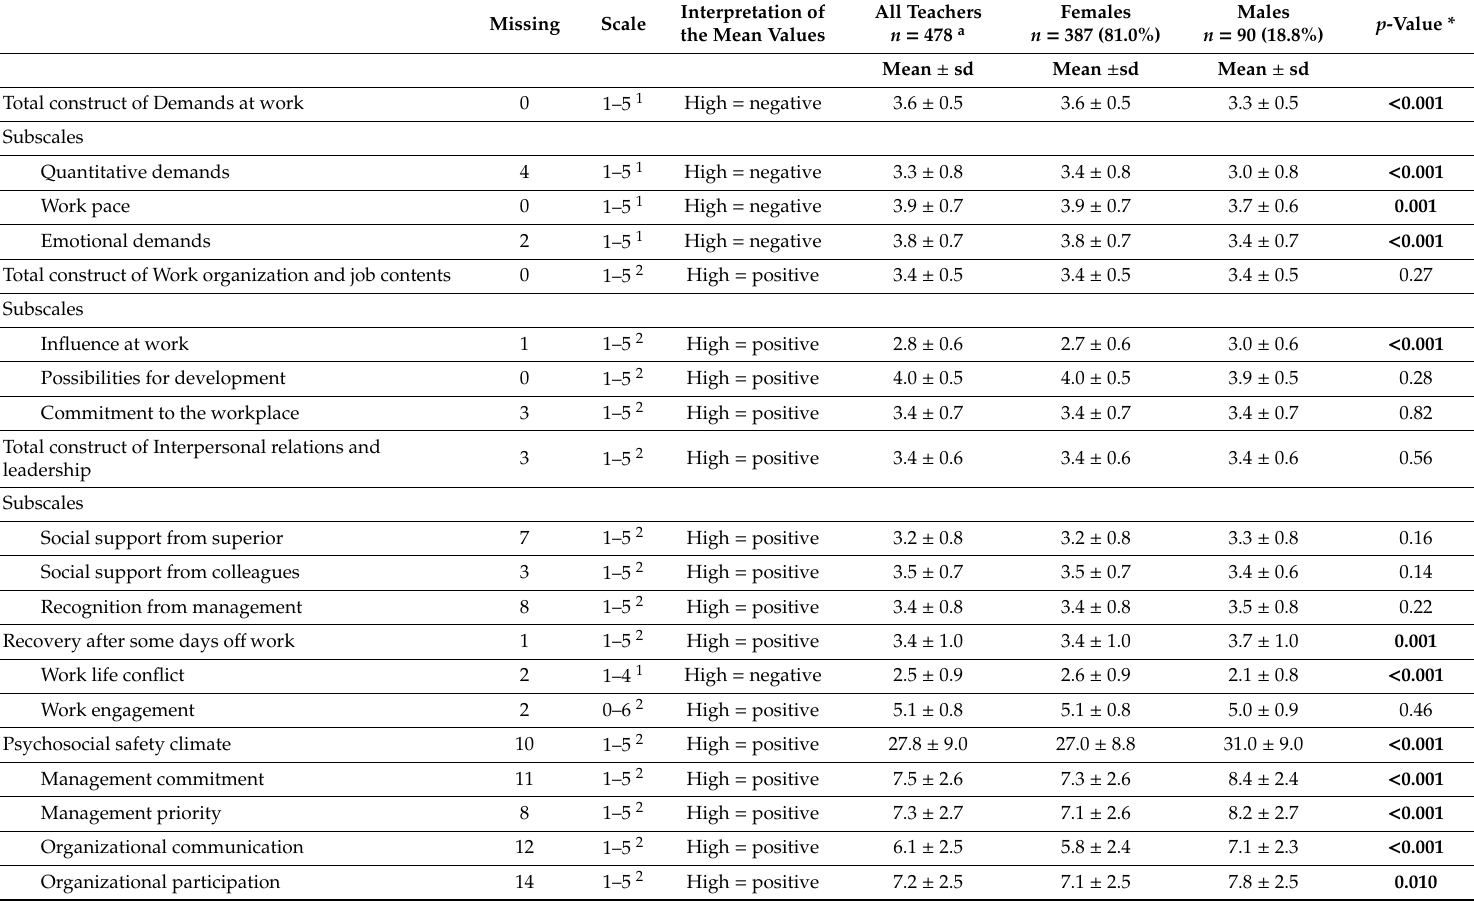
Table 3. Organizational and social factors for teachers at